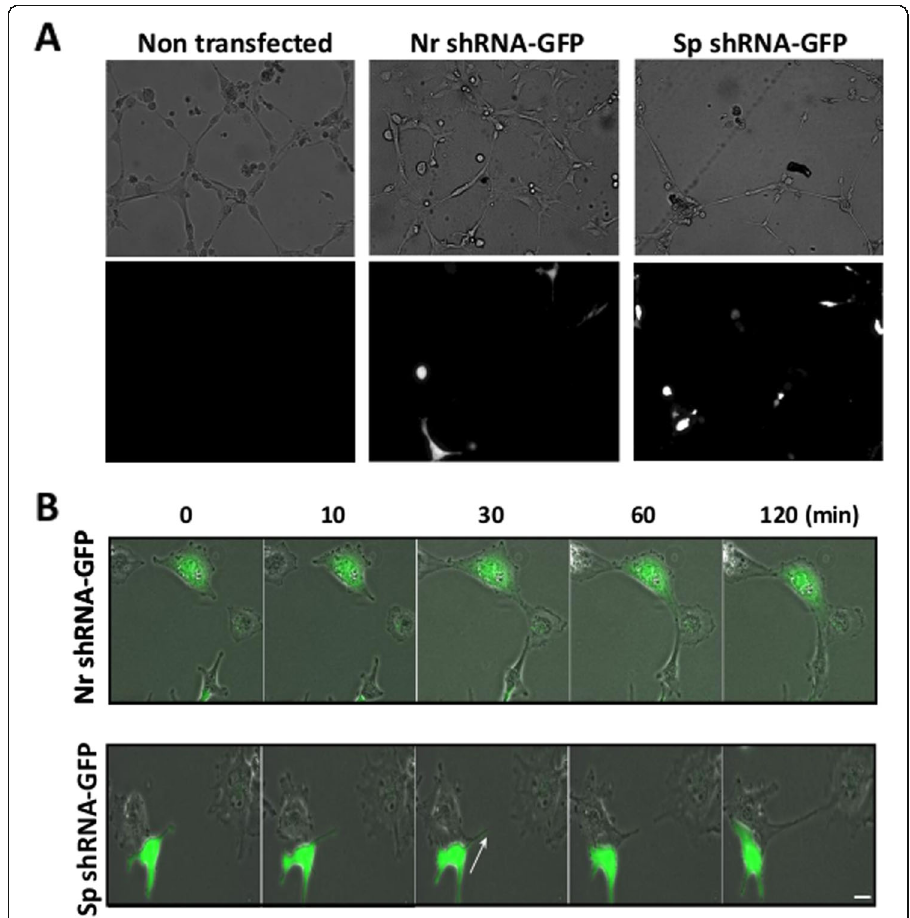
Fig. 6 Knockdown of α II-spectrin disturbs capillary tube formation in vitro. a Observation of capillary tube formation on Matrigel. HMEC-1 cells transfected with plasmids coding for GFP and either Nr shRNA or Sp shRNA were seeded 72 h after transfection at a density of 100,000 cells/ml on Matrigel (9.3 mg/ml) and observed 10 h after plating. Capillary tube formation is not disturbed in cells treated with Nr shRNA (middle panel) compared to the formation by non-transfected cells (left panel). The presence of spectrin-depleted cells (right panel) alters the formation of these structures in vitro: capillary tubes are less dense and remain incomplete. Camera, 10x magnification. Lower panel – fluorescent images of HMEC-1 cells transfected with plasmid coding GFP. b Kinetics of capillary tube formation. HMEC-1 cells transfected for 72 h with plasmids coding for GFP and either Nr shRNA or Sp shRNA were seeded on Matrigel and observed using video microscopy for 12 h. Spectrin-depleted cells form extensions but these extensions appear labile and disappear very quickly (arrow) as compared to cells transfected with control shRNA. Scale bar = 20 μ